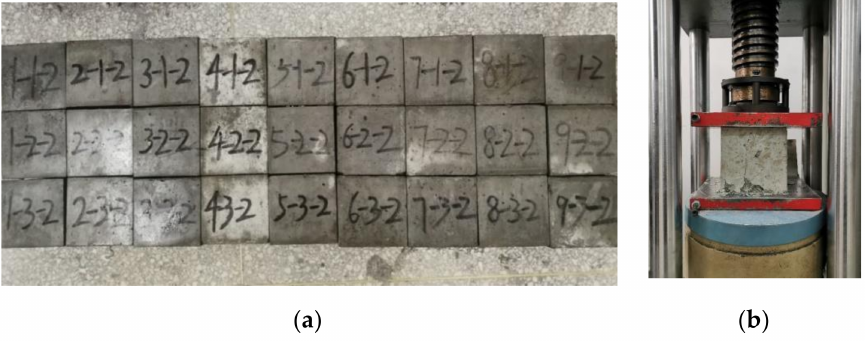
Figure 2. Compressive strength test of RAC cube specimens. ( a ) A part of the RAC cube specimens; ( b ) compressive strength